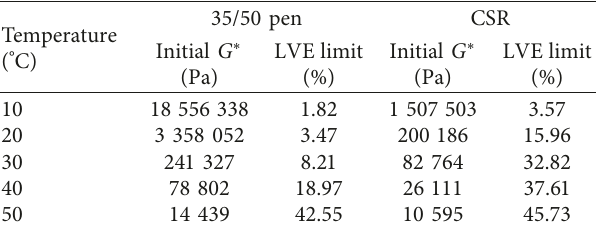
corresponding test frequency.